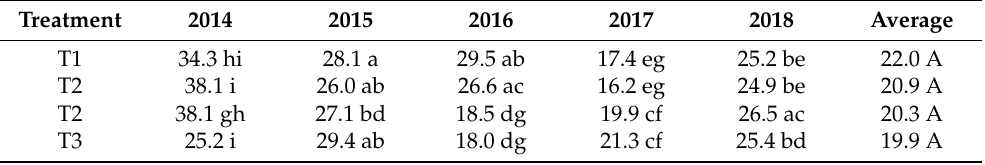
Table 4. Influence of the treatment on olive yield per tree between 2014 and 2018 (kg tree − 1 ). Treatment